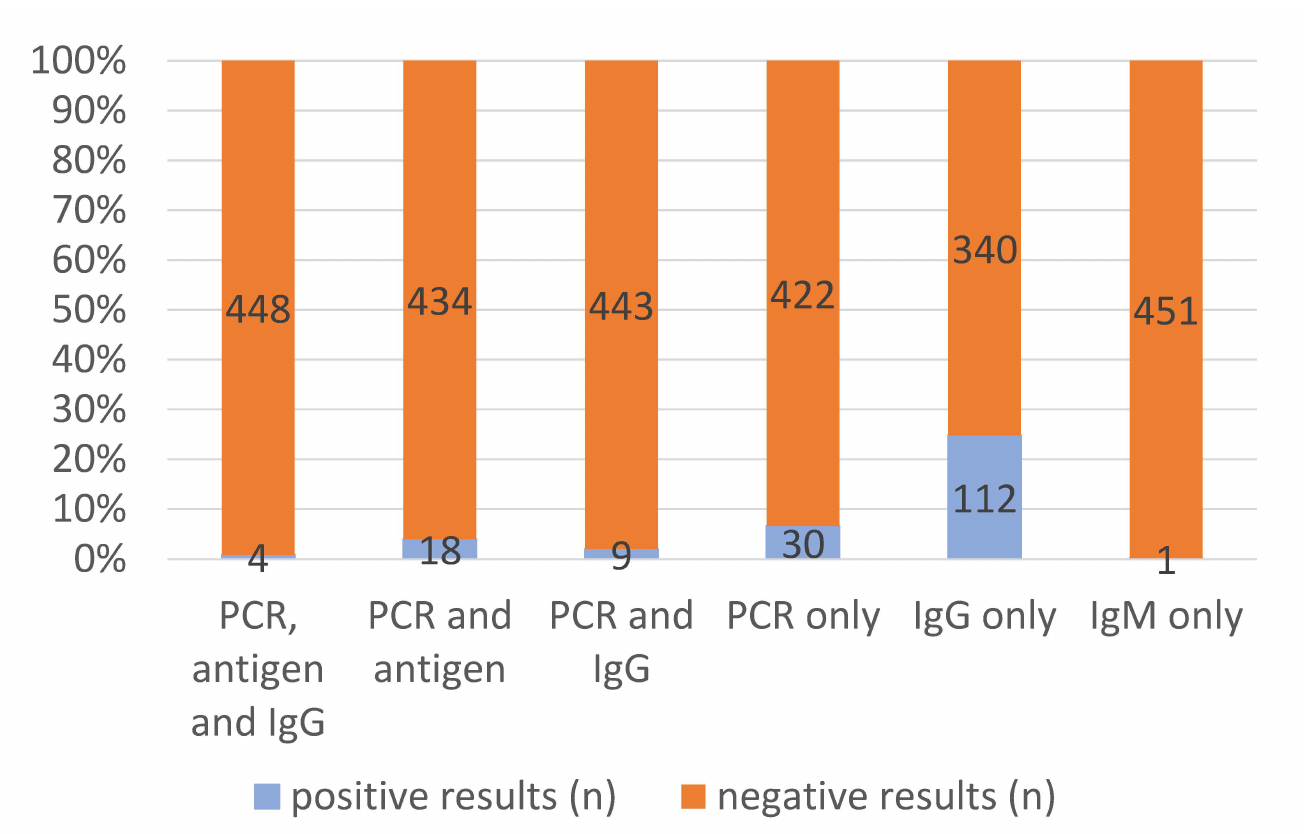
Figure 2. Numbers and proportions of positive results in various tests assays. Only combinations that really occurred are